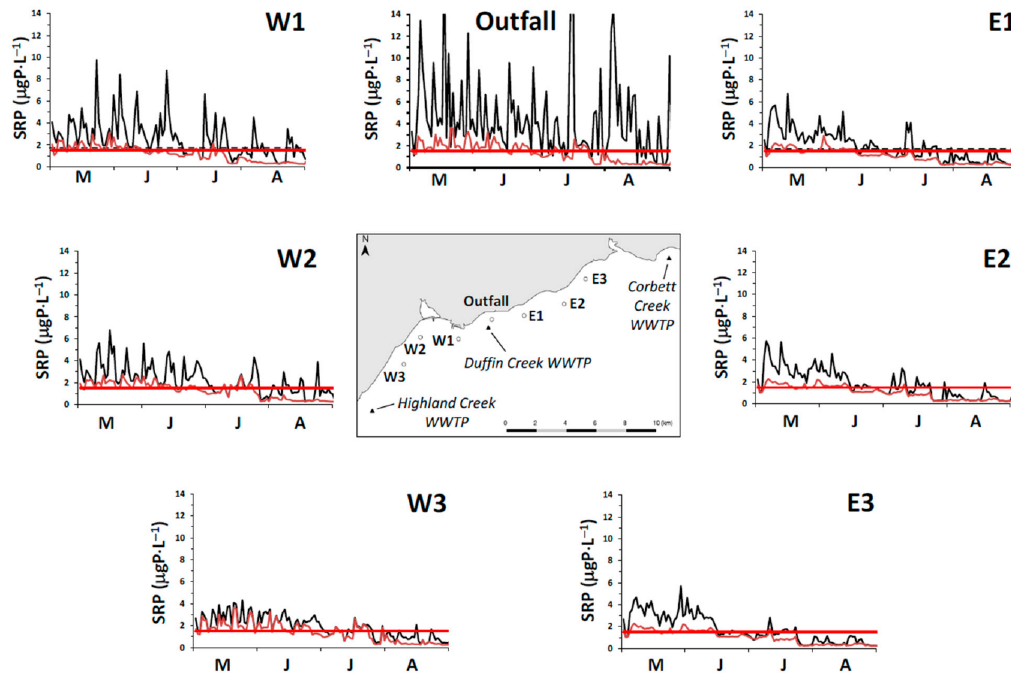
Figure 15. Model-simulated, multiple-source, bottom water SRP concentrations proximate to the Duffin Creek WWTP outfall and stations to the east and west. Simulations are for contemporary (baseline) treatment (black) and tertiary treatment (dark red), both with contemporary flow. Conditions are the contemporary case for discharges from the Highland Creek and Corbett Creek WWTPs. The red line represents the metric for P-limited growth (1.5 µ gP · L − 1